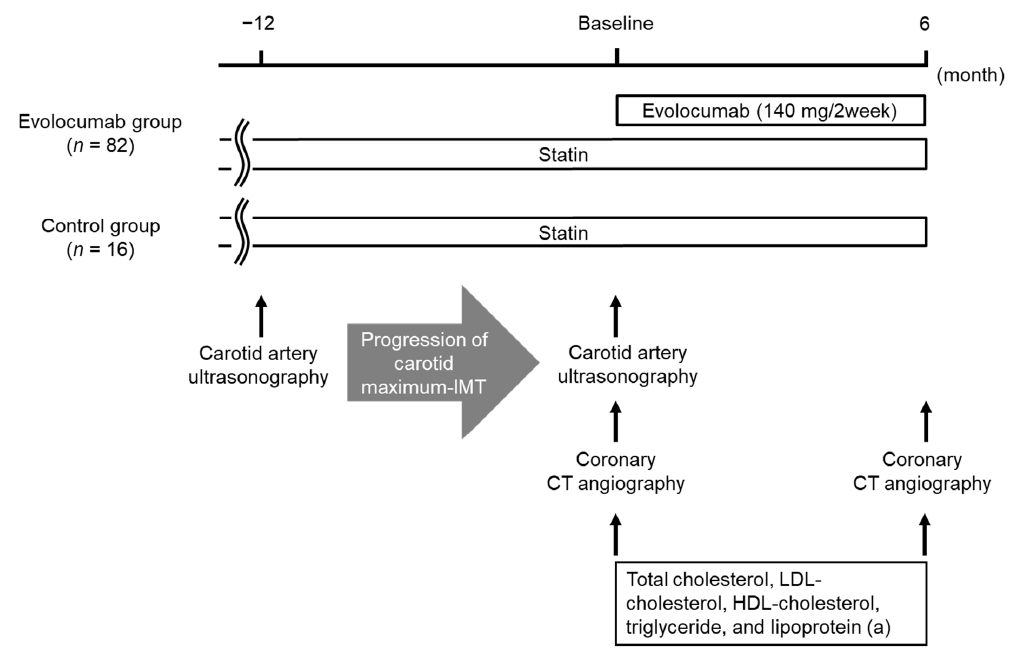
Figure 1. Study design. Abbreviations: CT, computed tomography; HDL, high-density lipoprotein; IMT, intima–media thickness; LDL, low-density lipoprotein.